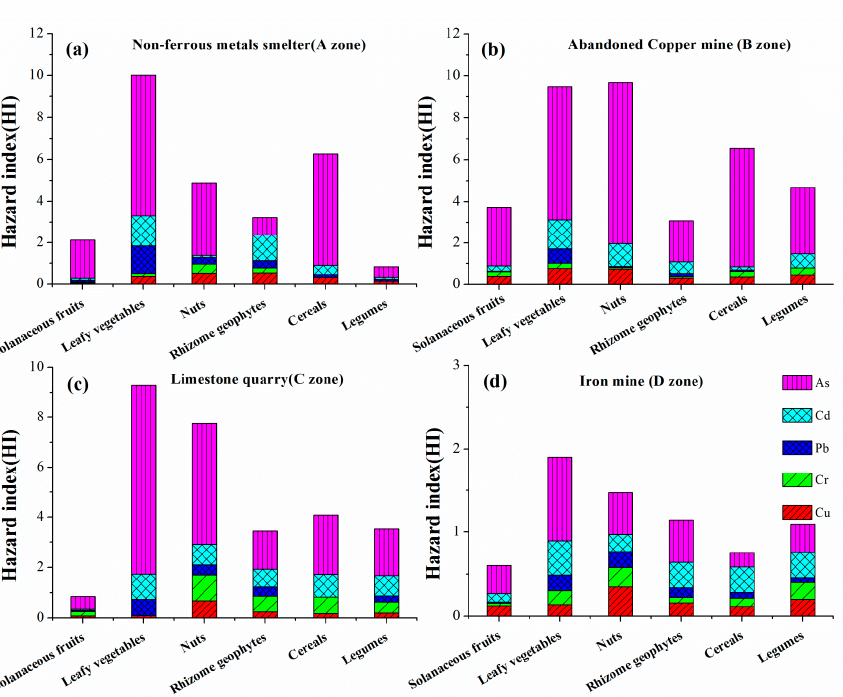
Figure 6. Target hazard quotients (THQ) and hazard index (HI) of different vegetable and crop types: ( a ) Non-ferrous metals smelter; ( b ) Abandoned copper mine; ( c ) Limestone quarry; ( d ) Iron mine.